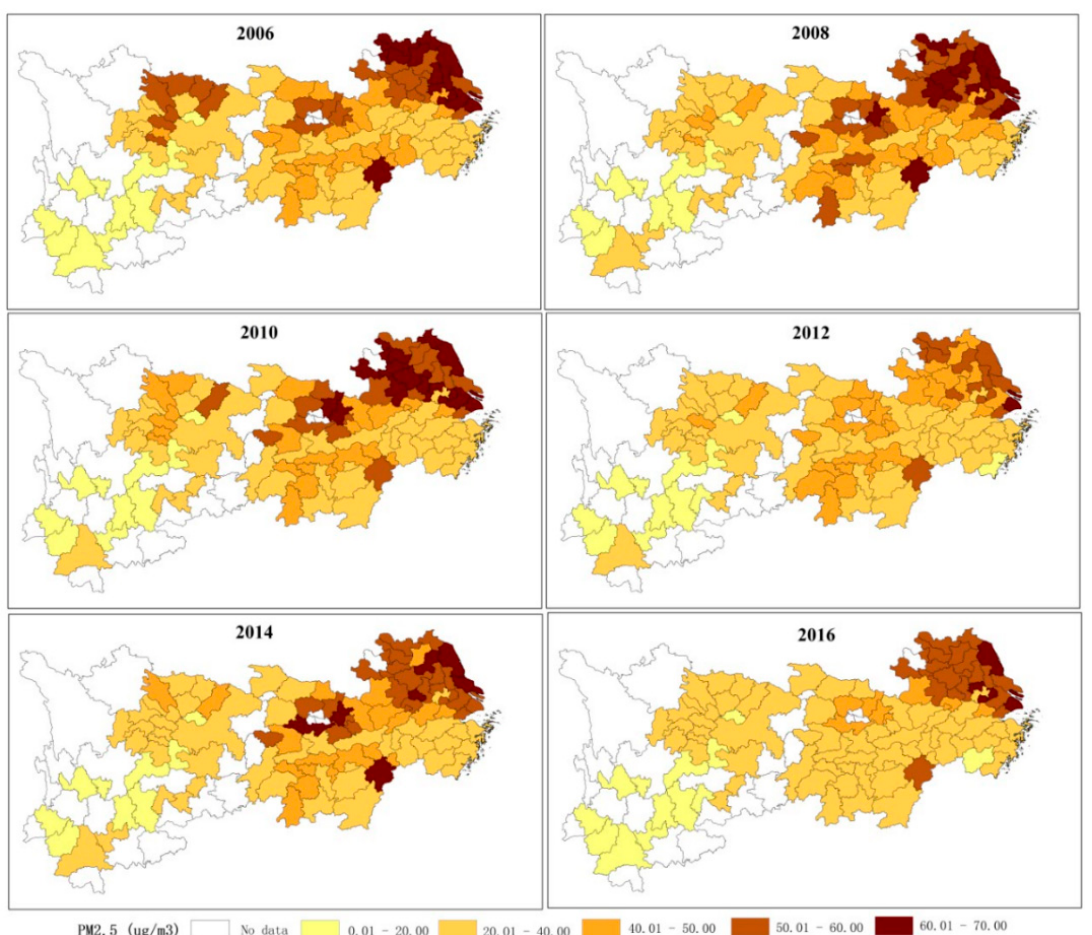
Figure 2. Spatial distribution evolution of PM 2.5 in Yangtze River Economic Belt (YREB). The six figures from the upper left corner to the lower right corner represent the spatial distribution of PM 2.5 in 2006, 2008, 2010, 2012, 2014, and 2016, respectively.